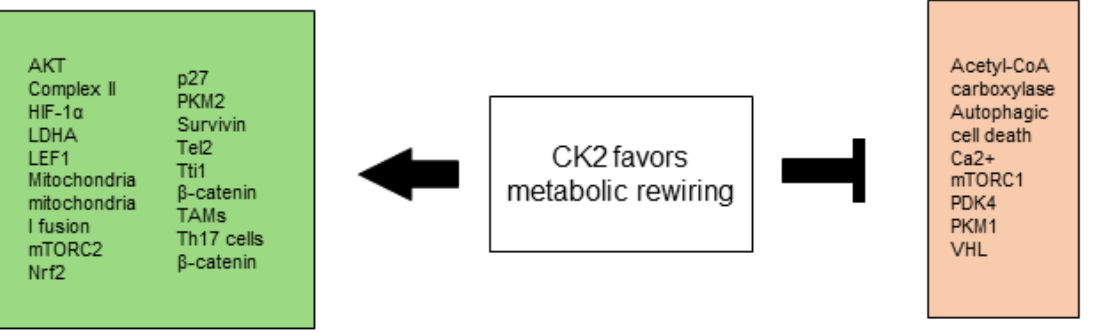
Figure 5. CK2-dependent modified proteins involved in metabolic rewiring. Proteins that are activated in this process by CK2 modification are shown on the left (highlighted in green), and proteins that are restricted in their function are shown on the right (highlighted in red).